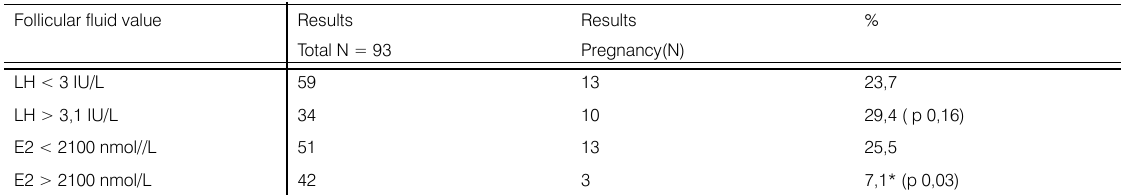
Table 3. Distribution of follicular hormone values according to cut off